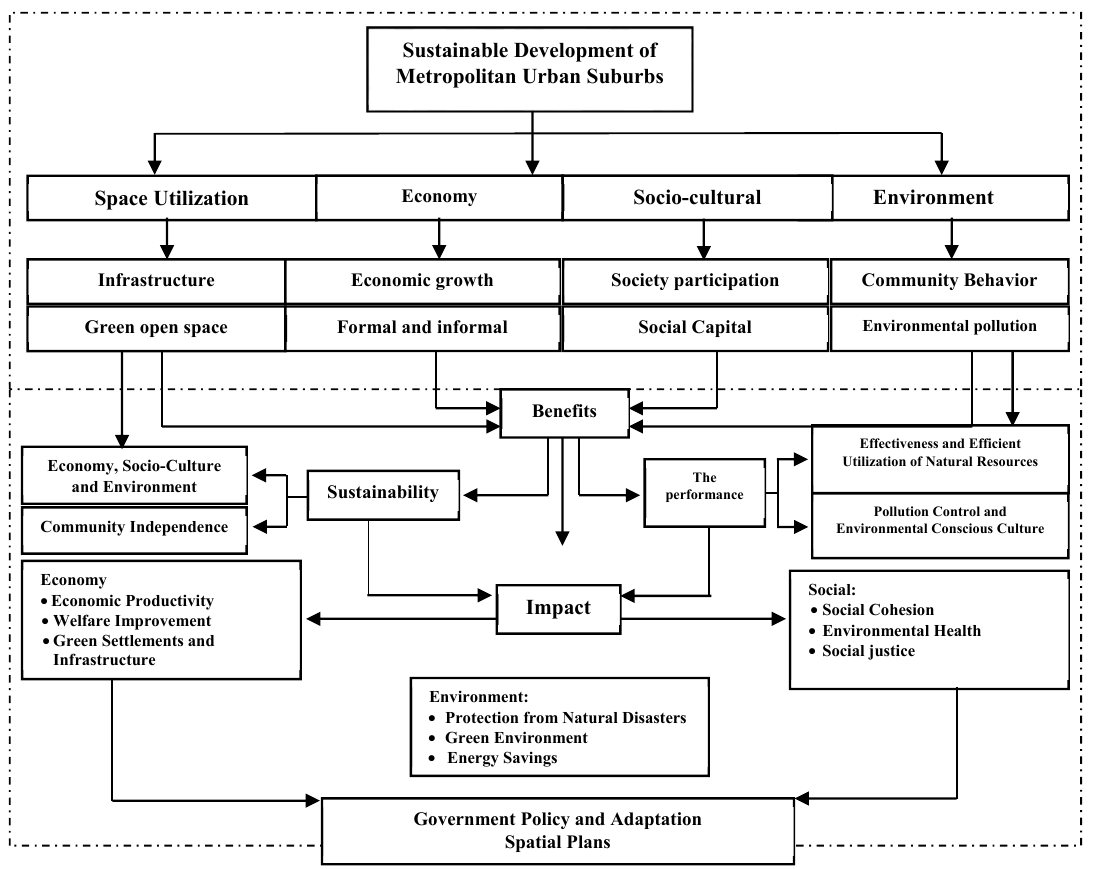
Figure 15. Sustainable Development of the Mamminasata Metropolitan Urban Suburbs. Source: author elaboration.